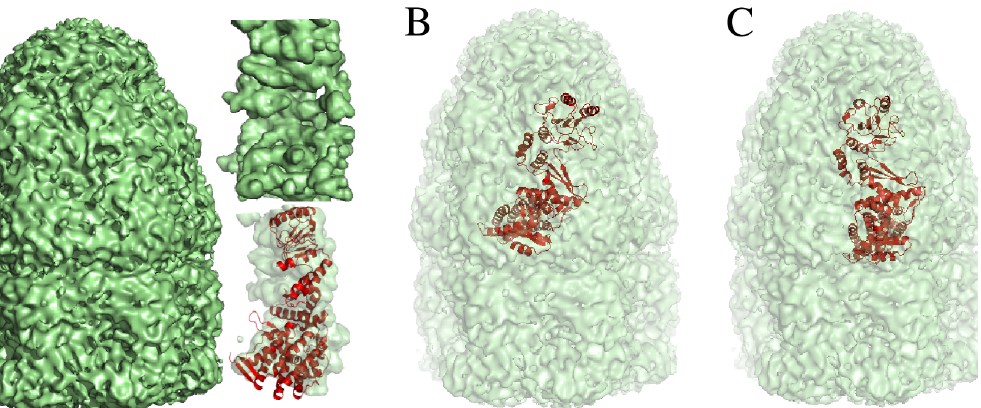
Fig 9. Fitting the PDB molecule P (1AONb) to the GroEL 3D EM map M (EMD 1461) at 7.7 Å . (A) Full 3D EM map M with segmented subunit M s (inset, top). The molecule P is fitted into M s using PF 2 fit (inset, bottom). (B) Initial guess for rigid-body fit into M . (C) PF 2 fit generates translational samples local to the initial guess to find the depicted correct result. Correctness is measured by deviation from the rigid-body fit in (A). The result has an RMSD of 0.3 Å from the fitting result in (A) and is ranked at number four in a run of PF 2 fit with angular resolution of